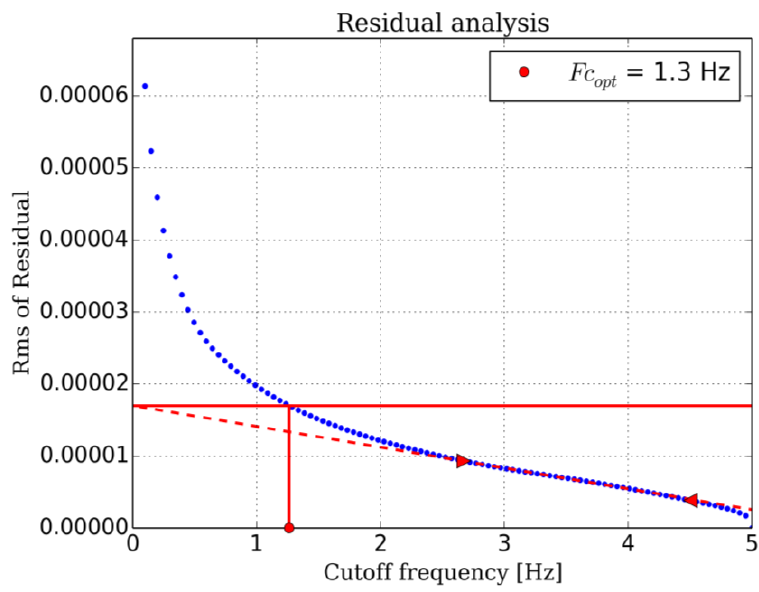
Figure 10. Residual analysis: plot of the residual value of typical breathing data for different cutoff frequencies. The optimal cutoff is chosen at the point where noise contribution equals signal contribution.